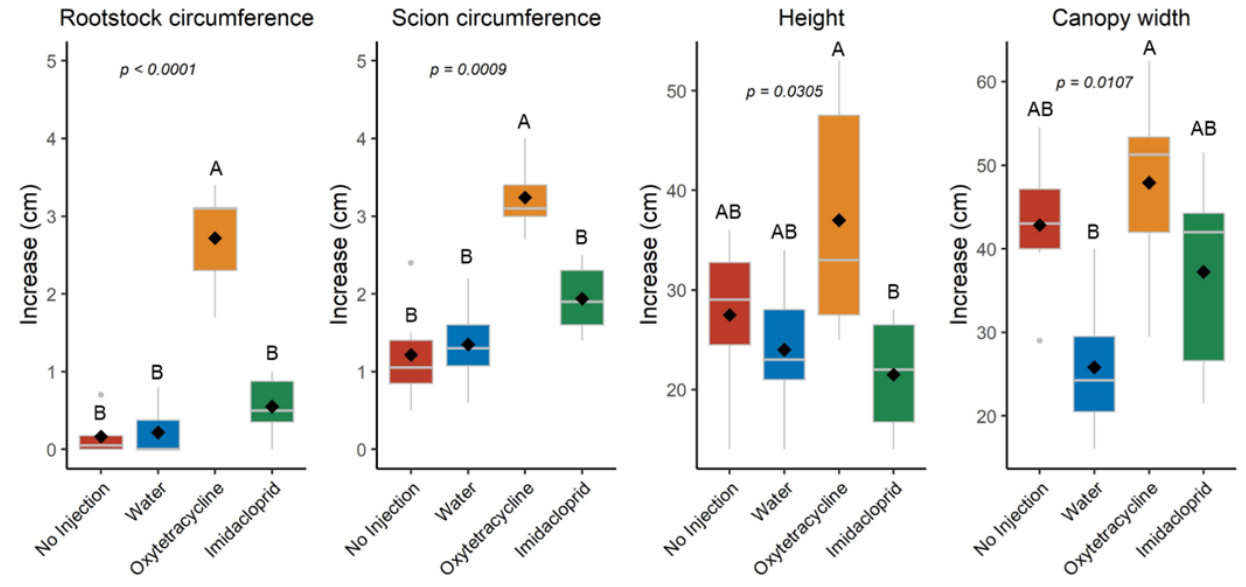
Figure 7. Increase in rootstock circumference, scion circumference, tree height, and canopy width from October 2020 until February 2022 after injection in October 2020 and April 2021. Different letters indicate significant differences ( p < 0.05) according to Tukey’s honest significant difference test. Letters not shown when differences were not significant.